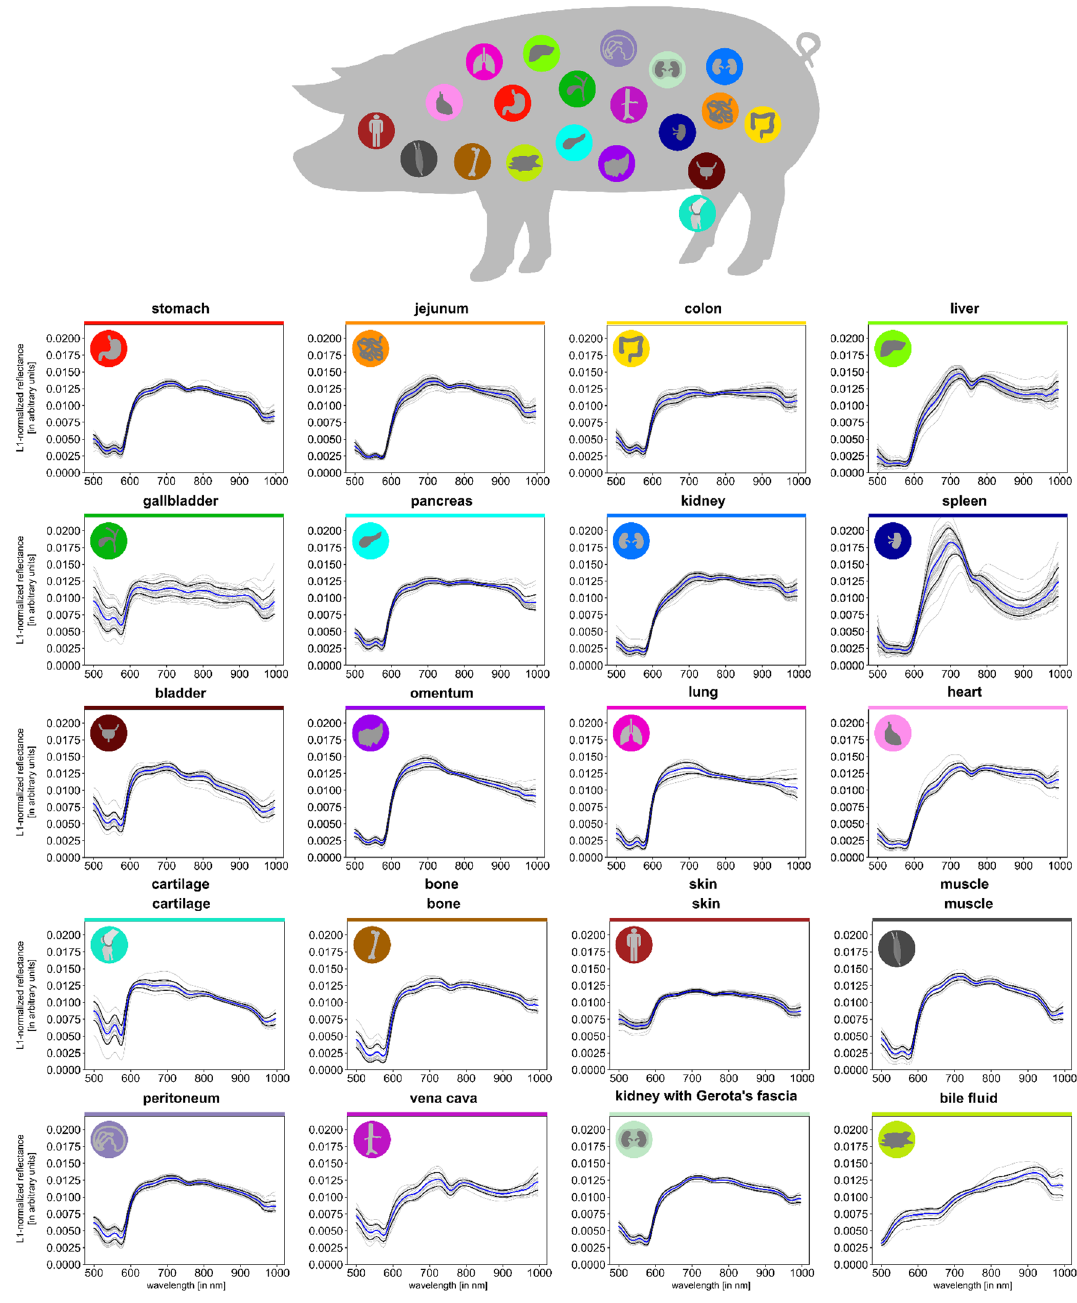
Figure 1. Tissue atlas comprising spectral fingerprints of 20 organs and specific tissue types. Stomach (A = 39; n = 849), jejunum (A = 44; n = 1546), colon (A = 39; n = 1330), liver (A = 41; n = 1454), gallbladder (A = 28; n = 526), pancreas (A = 31; n = 530), kidney (A = 42; n = 568), spleen (A = 41; n = 1353), bladder (A = 32; n = 779), omentum (A = 23; n = 570), lung (A = 19; n = 652), heart (A = 19; n = 629), cartilage (A = 15; n = 586), bone (A = 14; n = 537), skin (A = 43; n = 2158), muscle (A = 15; n = 560), peritoneum (A = 28; n = 2042), vena cava (A = 15; n = 353), kidney with Gerota’s fascia (A = 18; n = 393), bile fluid (A = 13; n = 362). A indicates the number of animals; n indicates the number of measurements in total. Graphs depict mean reflectance (ℓ1-normalized on pixel-level) of individual pigs (gray) as well as overall mean (blue) ± 1 standard deviation (SD) (black) with wavelengths from 500 to 1000 nm on the x-axis and reflectance in arbitrary units on the